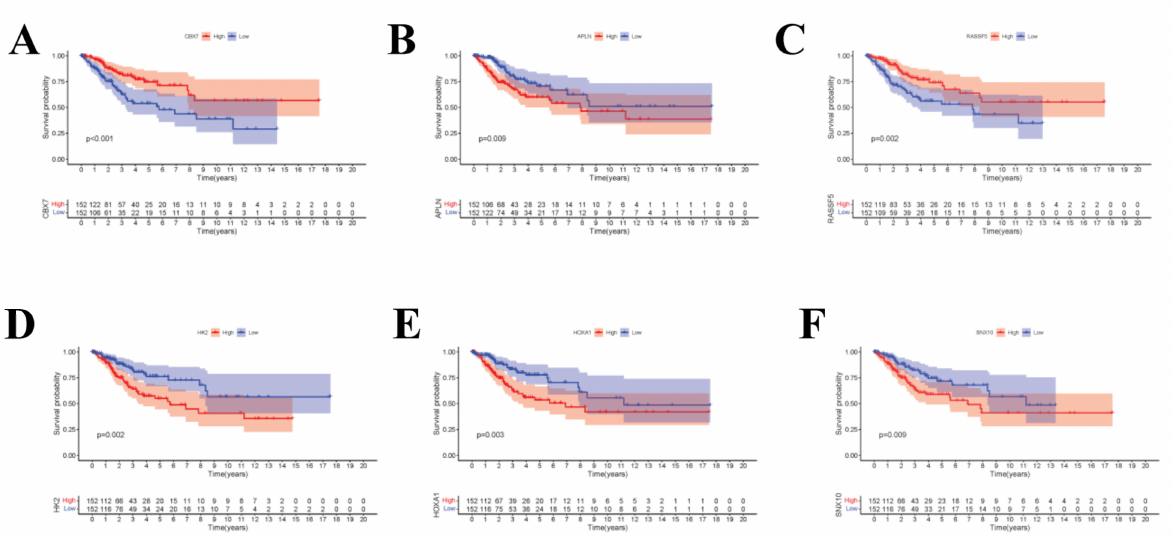
Figure 4. ( A – F ) The K–M survival curves of the circRNA-related mRNAs based on the expression, where showed genes significantly correlated with prognosis ( p -value <